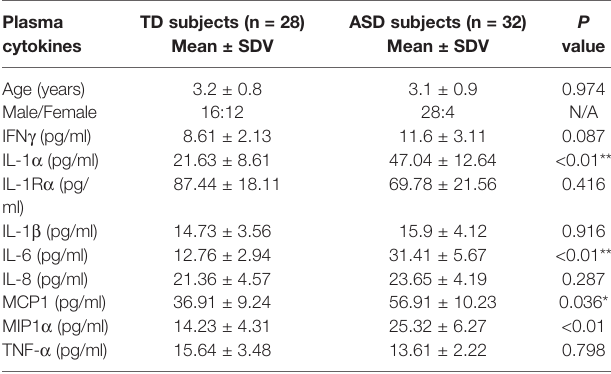
TABLE 1 | Cytokine levels in plasma for typically developing (TD) and autistic (ASD) children. Plasma TD subjects (n = 28) cytokines Mean ± SDV